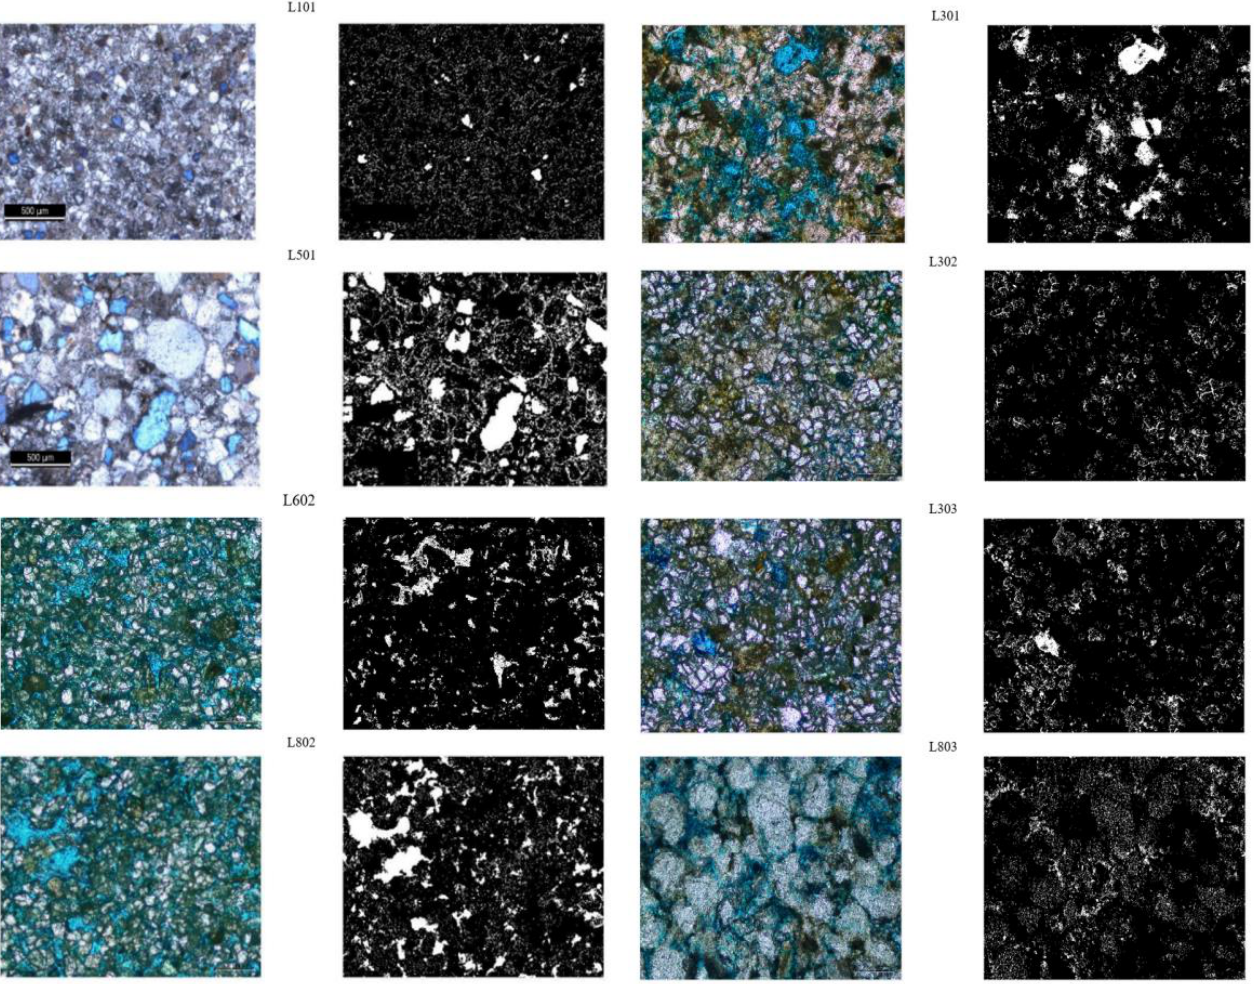
Figure 18. Thin sections and their binary components are based on blue epoxy color threshold. Table 2. The porosity in percent (%) for the blue-impregnated thin sections. Sample